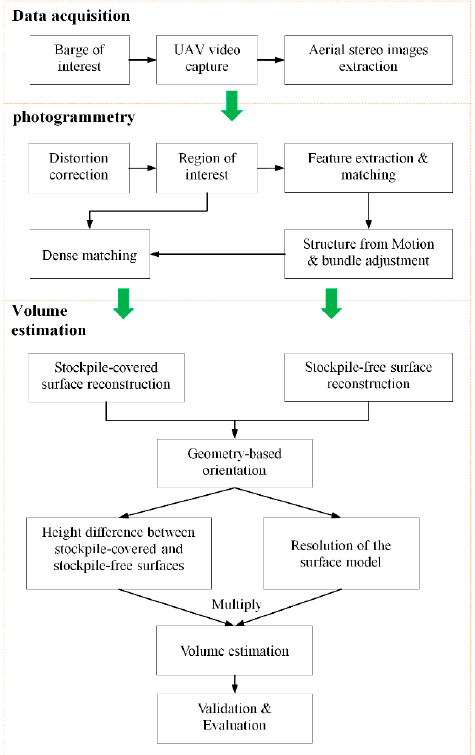
Figure 7. Workflow of the volume estimation of stockpiles carried on barges using GCP-free unmanned aerial vehicle (UAV) photogrammetry.